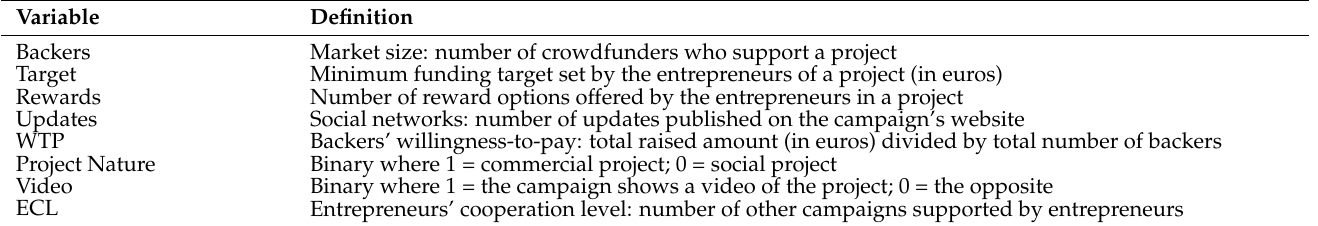
Table A1. Description of